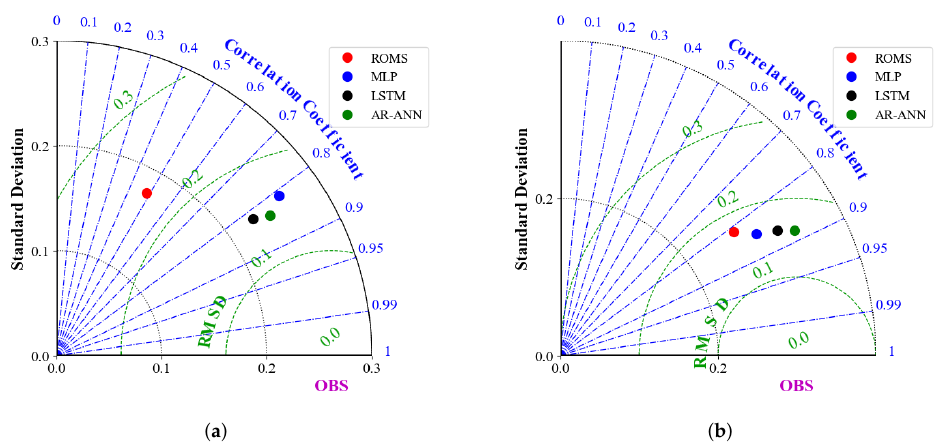
Figure 10. Taylor diagram for tidal current speed comparing estimation runs’ statistics for the R, RMSE, and STD of various models. ( a ) Taylor diagram of tidal current speed u; ( b ) Taylor diagram of tidal current speed v.